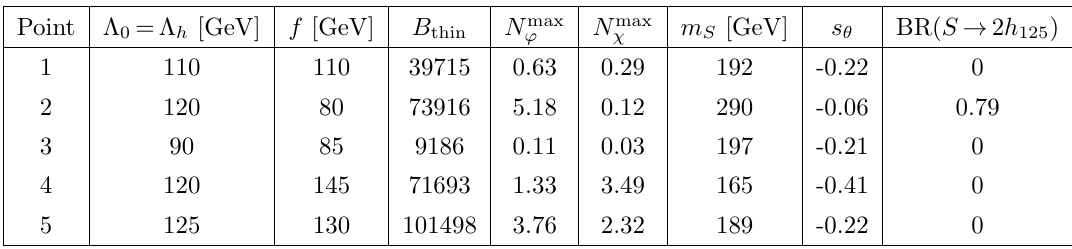
Table 1 . Phenomenology at the example